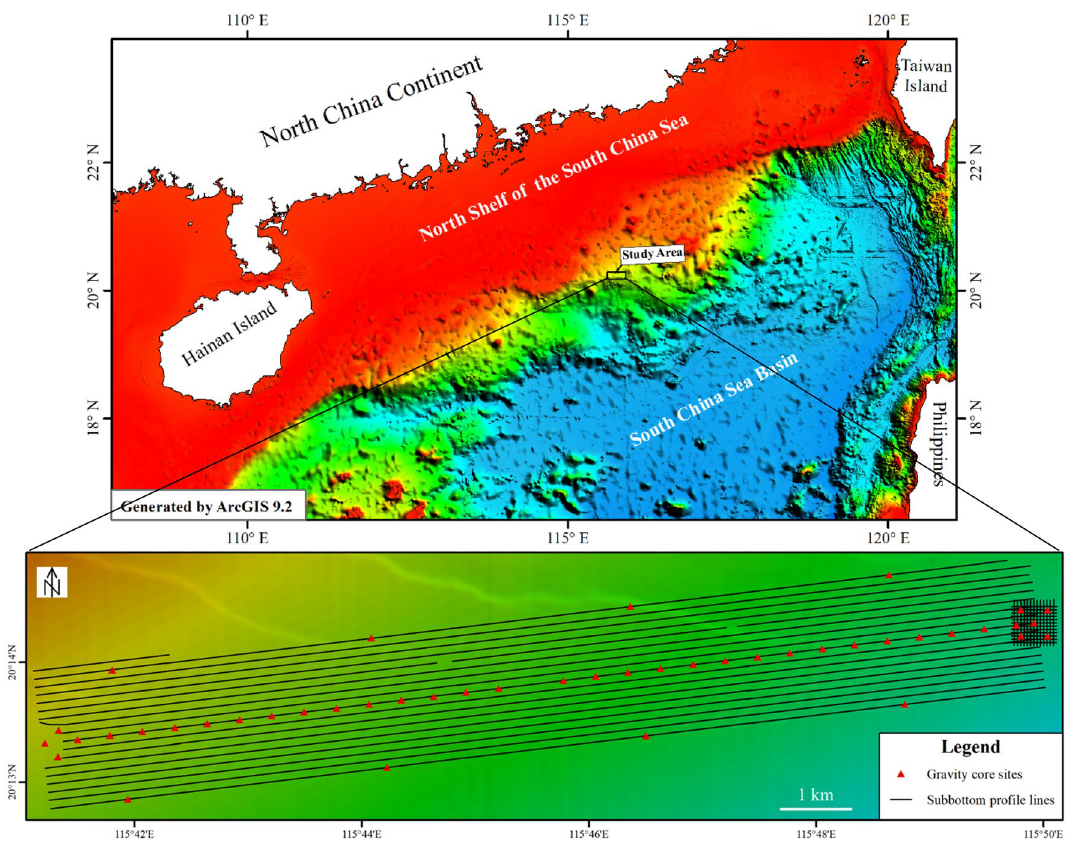
Figure 1. Location of the study area and distribution of survey lines and sampling stations (Generated by ArcGIS 9.2, Data source: Global seabed topography GECBO 15 ″ × 15 ″ grid data, http:// www. gebco. net): the sub- bottom profile lines are 270 km, with 45 sampling